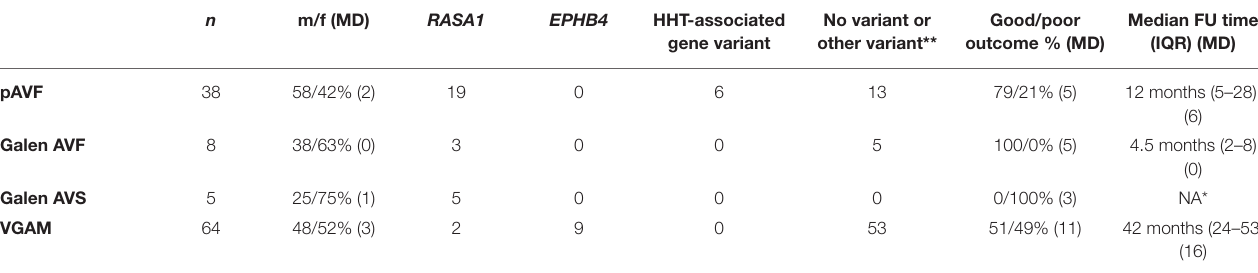
TABLE 1 | Number of pathogenic variants found in the four types of arteriovenous malformations and patient outcome at the last clinical follow-up.